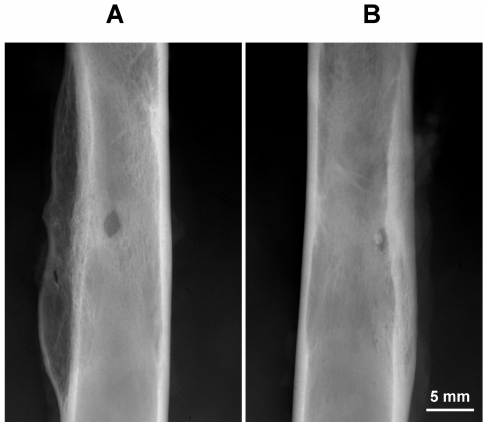
Figure 1. Representative mid-shaft radiographs of two femurs 60 days after the surgery. Note in both radiographs how the shape of hole changes from round (original) to ellipsoidal. Note also how the control hole ( A ) has a greater size than that of a BGSr filled hole ( B ).